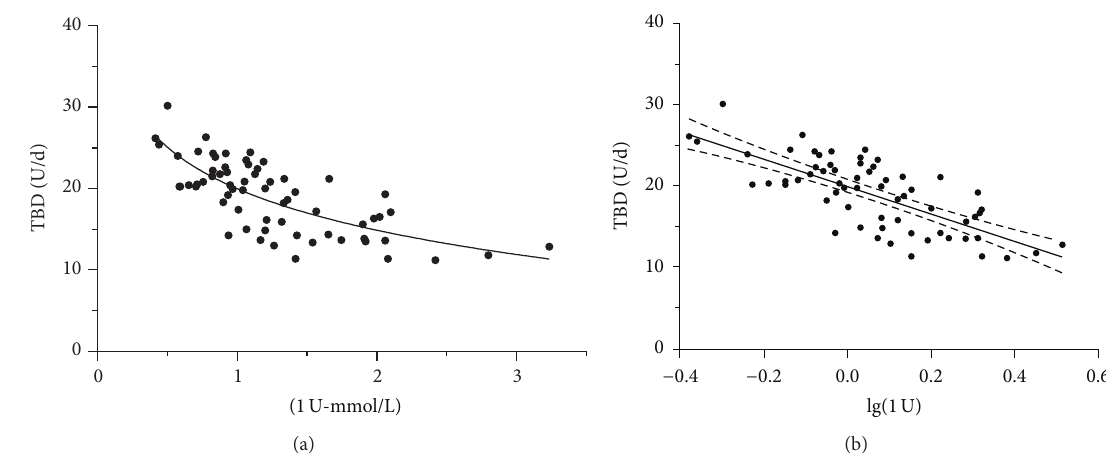
Figure 1: (a) TBD was decreased with the ratio of RBG/RII: 𝑟 = −0.710 ( 𝑛 = 65 ), 𝑃 < 0.01 . (b) Correlations of the ratio of RBG/RII (log transformed) with TBD in 65 subjects: 𝑟 = 0.740 , 𝑃 < 0.01